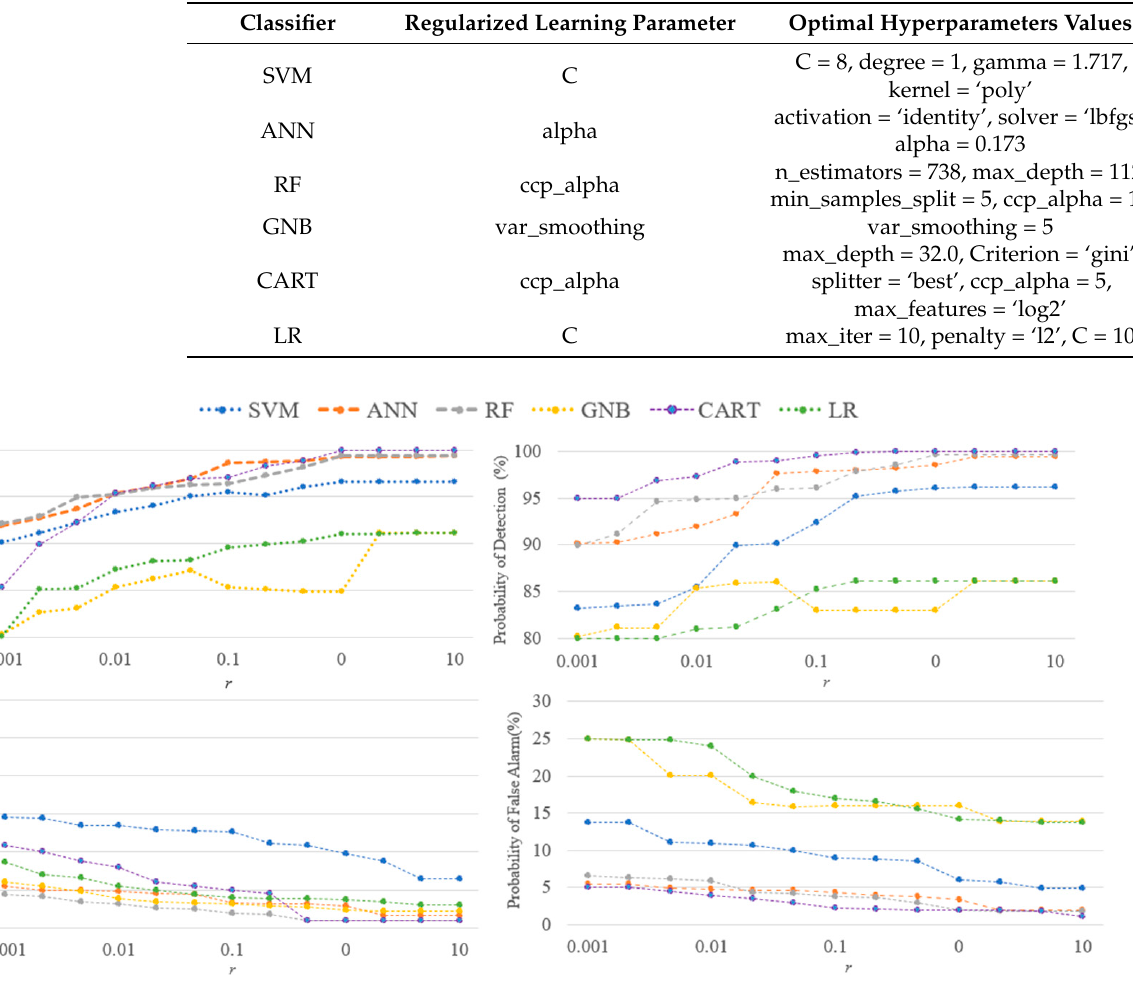
Figure 3. Impact of regularization learning parameters on model performance.